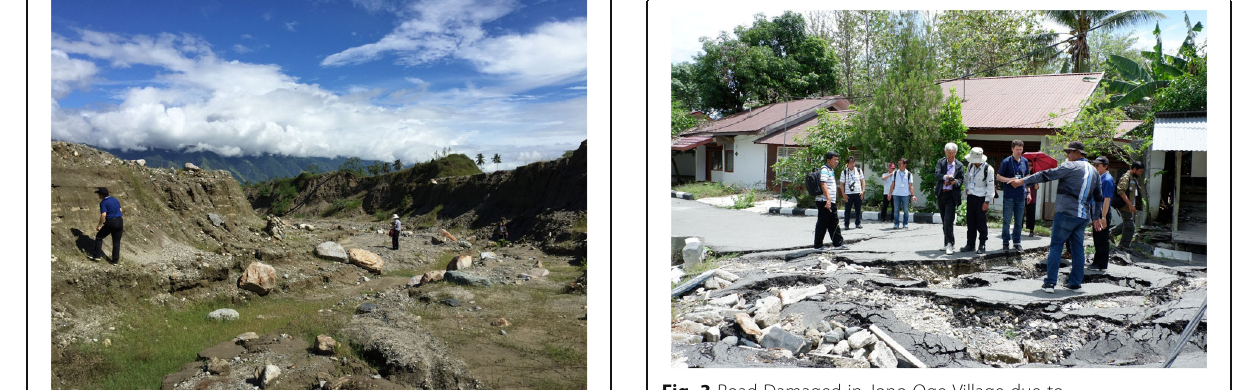
Fig. 3 Road Damaged in Jono Oge Village due to ground movement